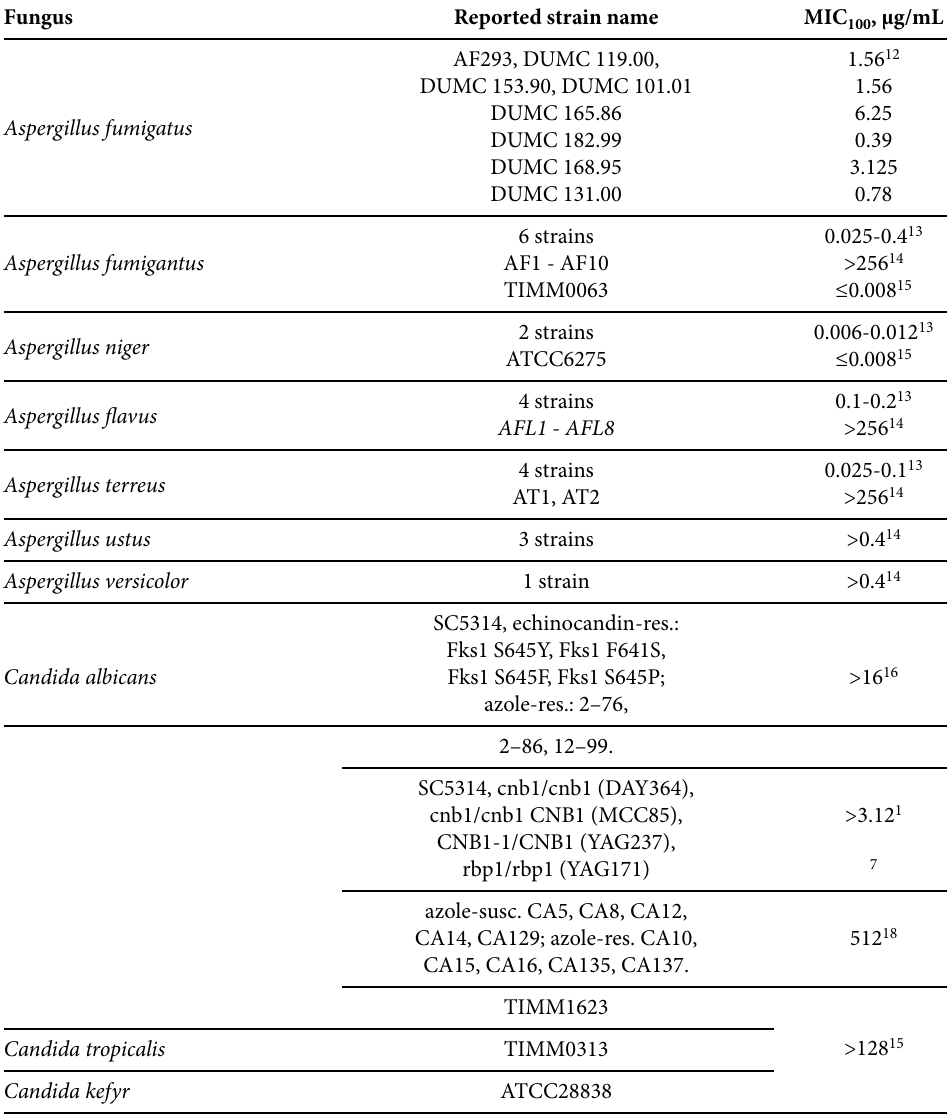
Table 1. Summary of reported antifungal activity of tacrolimus (FK506)